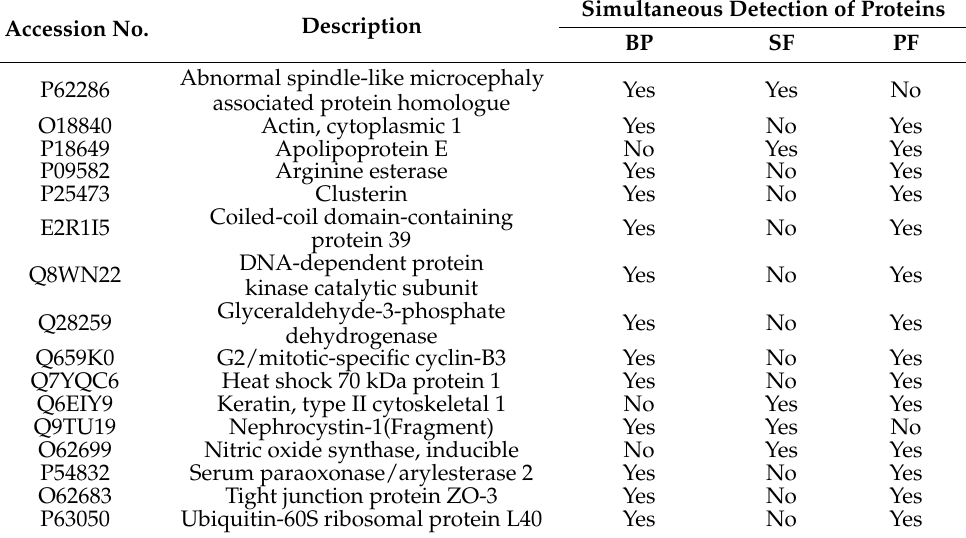
Table 2. Proteins simultaneously identified in two tissues among those assessed: blood plasma (BP), semen sperm-rich fraction (SF), and semen prostatic fraction (PF) from Beagle-breed dogs (protein identification by